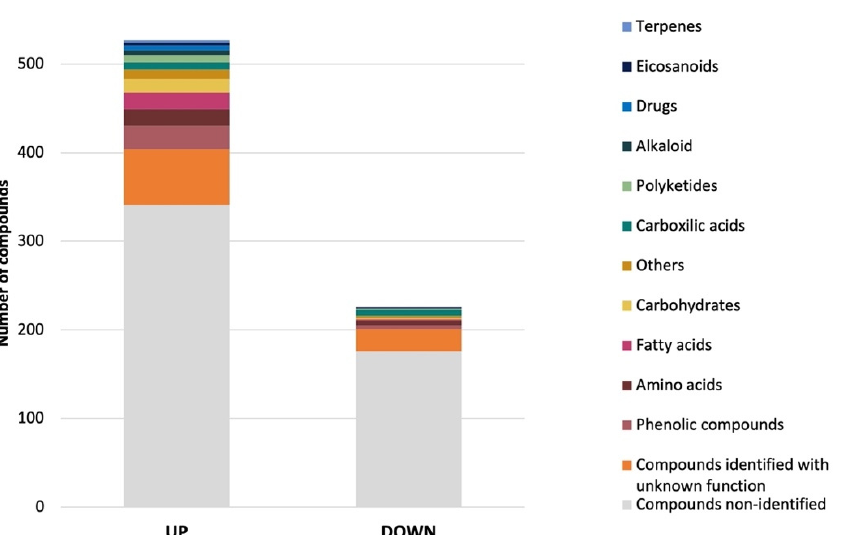
Figure 7. Structural classification of up and down regulated ( p < 0.01) metabolites produced by Aspergillus affinis CMG 70, grown in the presence of sea salt, in comparison to A. affinis CMG 70, grown in the absence of sea salt.